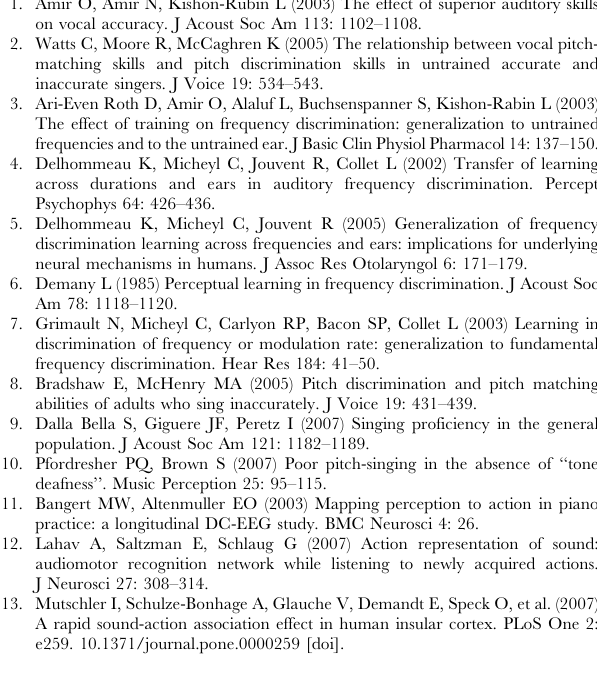
Table S1 Regions of peak neural activity during the simple singing task compared with voice perception, prior to training. All peak/cluster ps # 0.05, corrected. ACC = anterior cingulate cortex; BA = Brodmann area; M1 = primary motor cortex; PAC = primary auditory cortex; SMA = supplementary motor area; STG = superior temporal gyrus; vPMC = ventral premotor cortex.